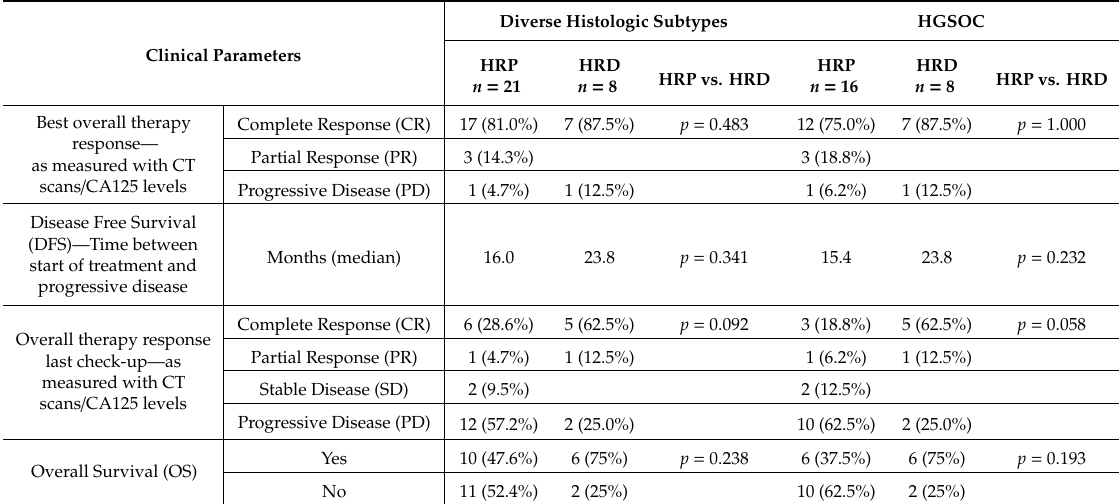
Table 2. Correlation between RECAP score and clinical response.